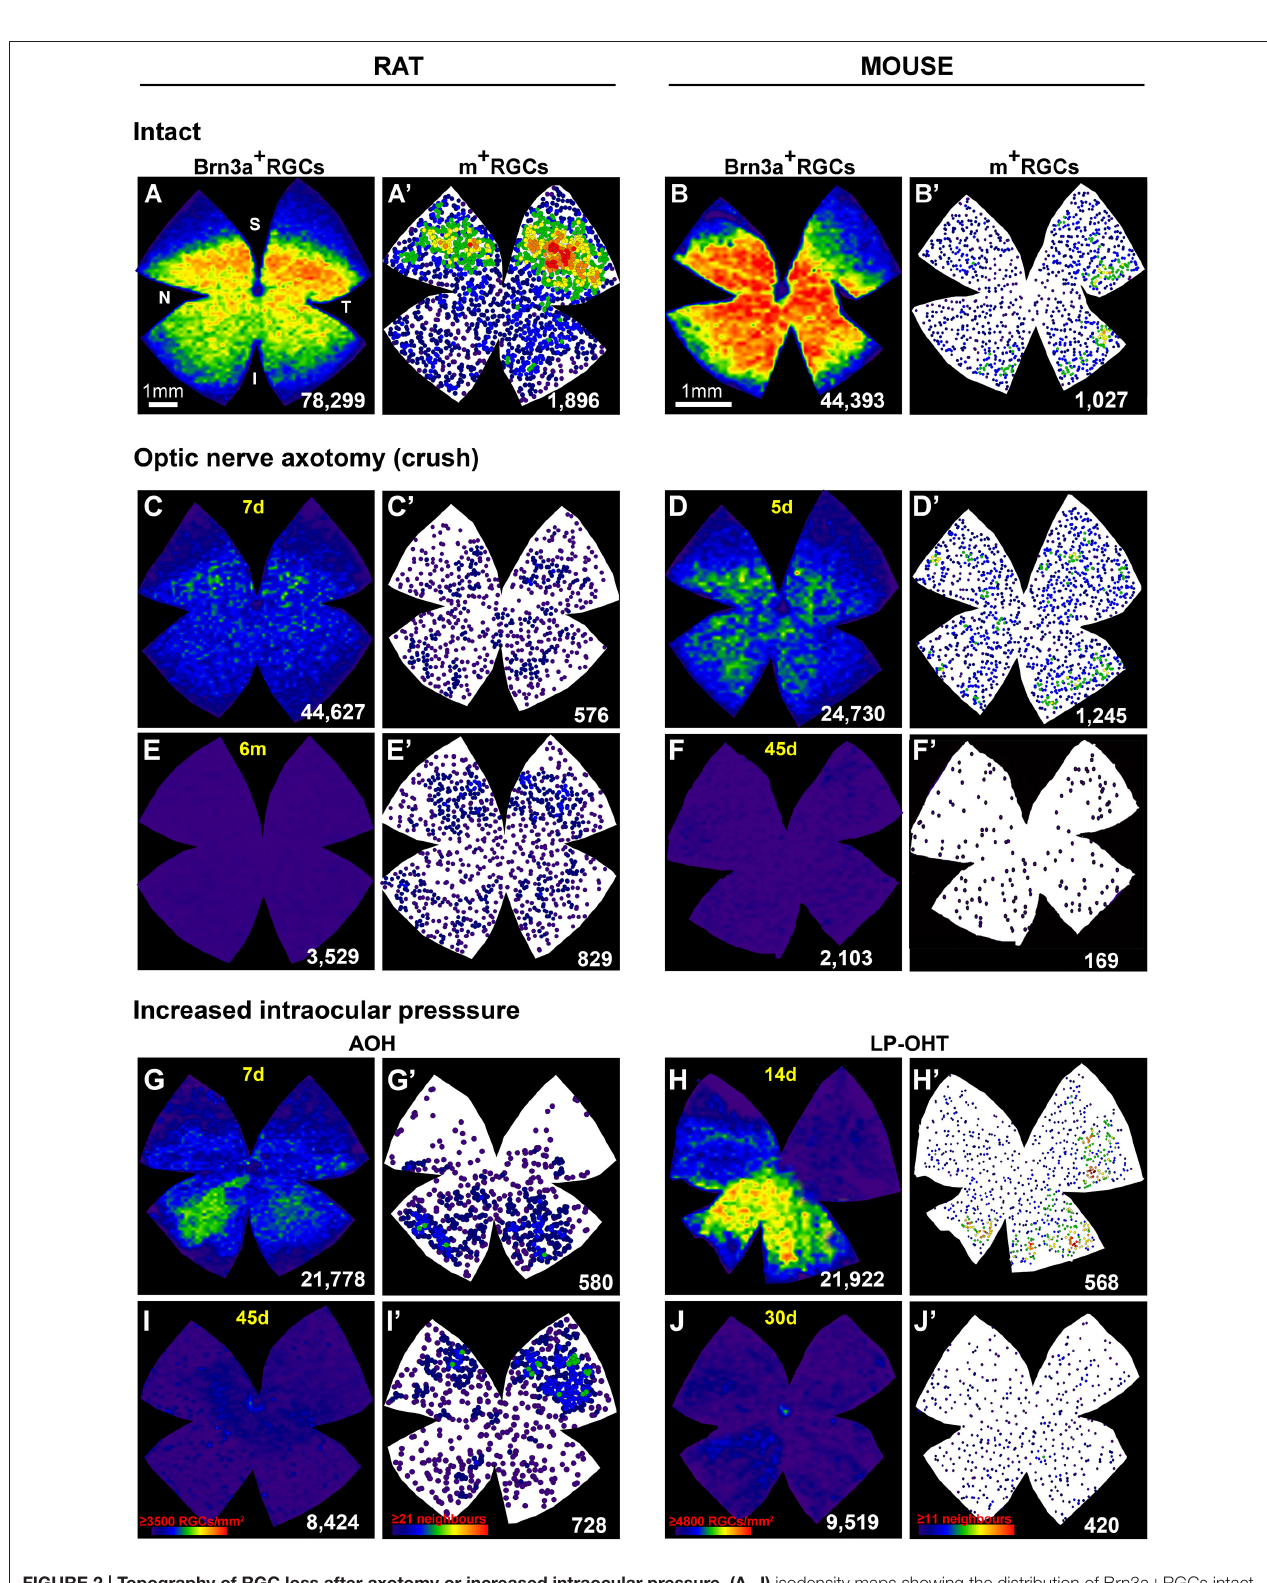
FIGURE 2 | Topography of RGC loss after axotomy or increased intraocular pressure. (A–J) isodensity maps showing the distribution of Brn3a + RGCs intact (A,B) or injured (C–J) retinas from rat (A–I) or mouse (B–J) . ( A’–J’) : neighbor maps showing the distribution of melanopsin + RGCs in the same retinas as ( A–J). (C–F